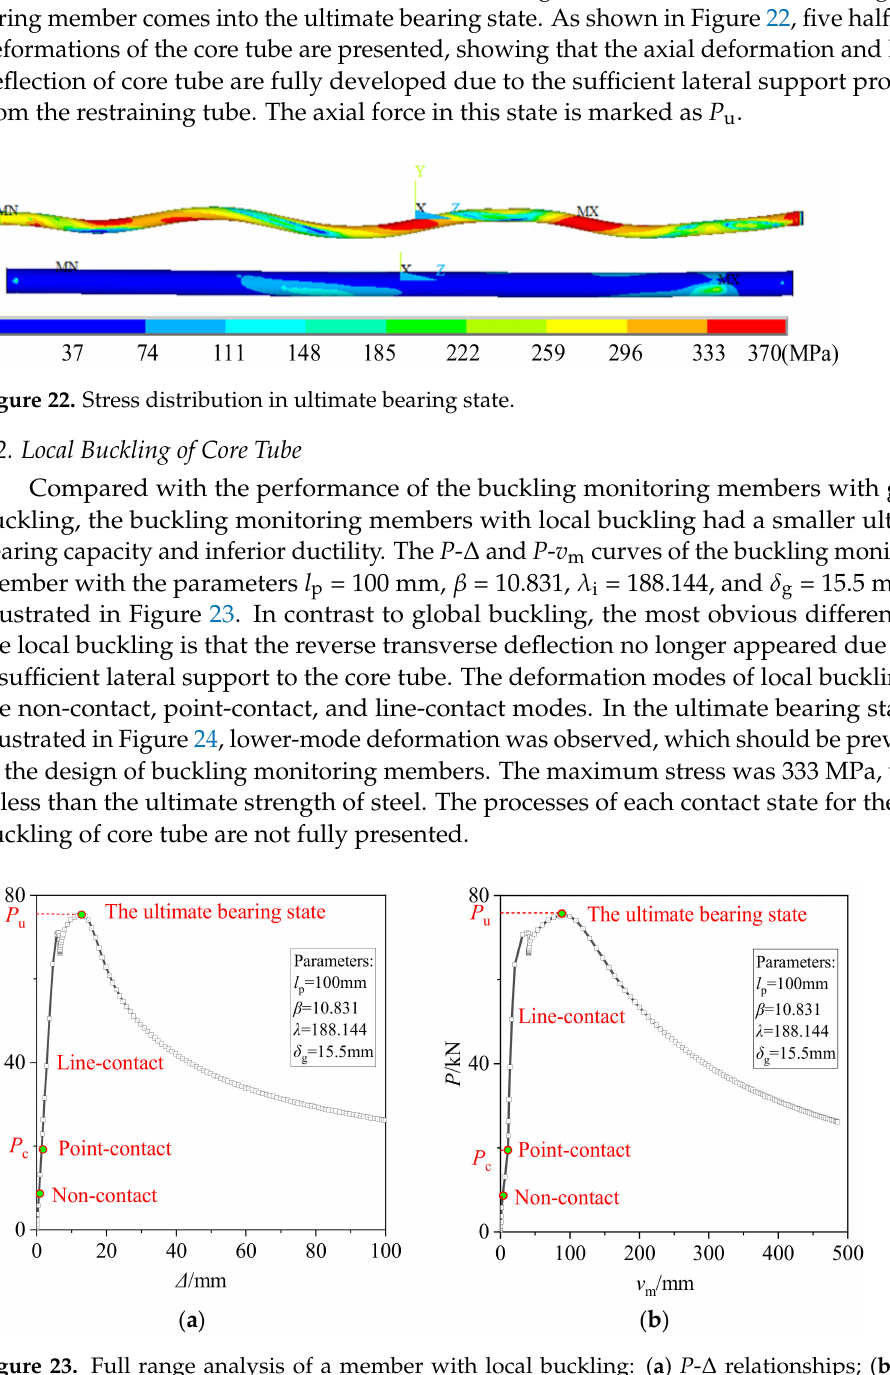
Figure 23. Full range analysis of a member with local buckling: ( a ) P - ∆ relationships; ( b ) P - v m